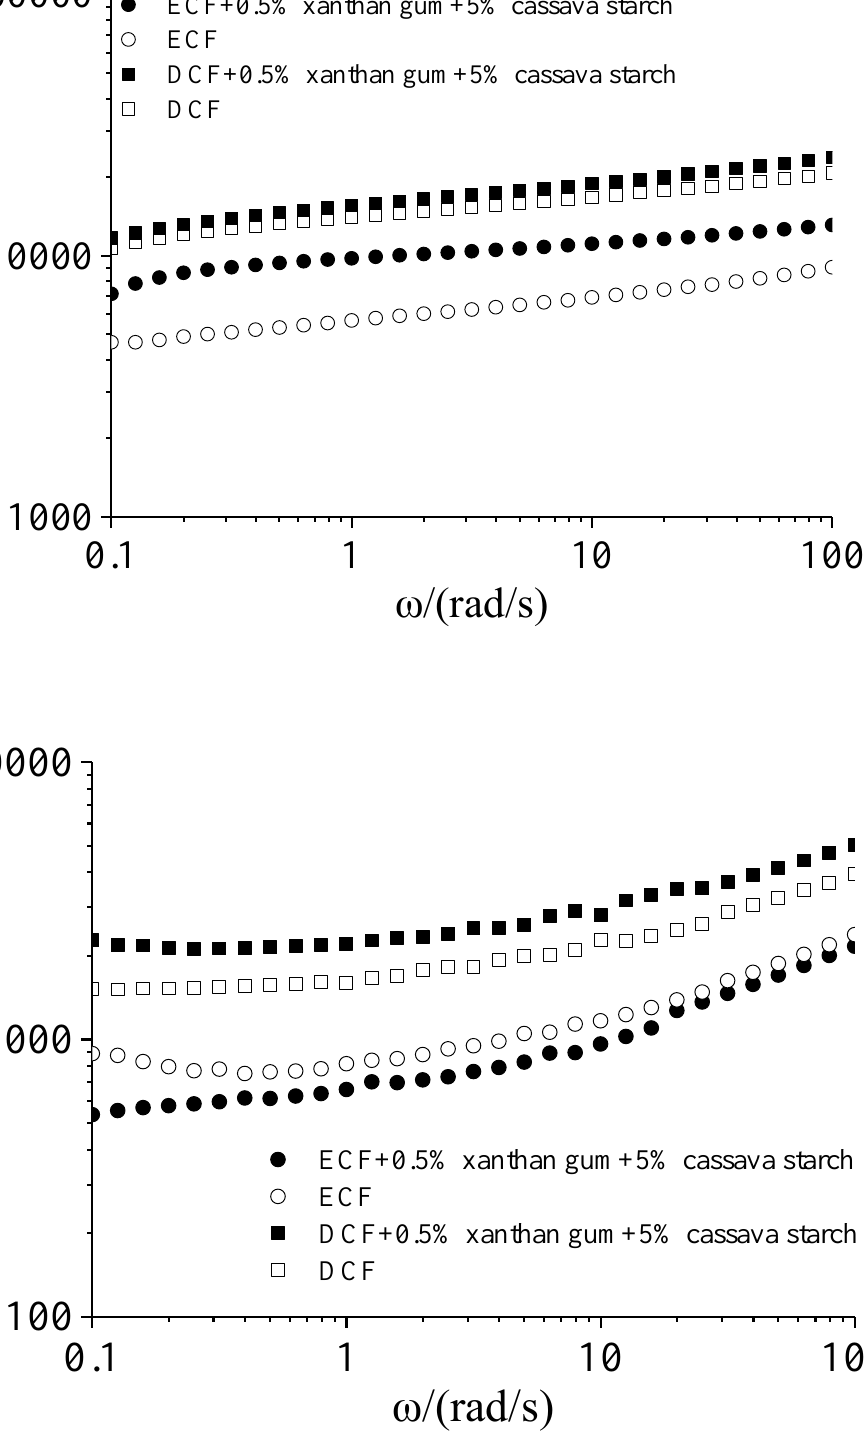
Figure 6. Frequency sweep of tortillas. ( A ): Storage modulus G′; ( B ): loss modulus G″. DCF: dry-milling corn flour; WCF: wet-milling corn flour; ECF: enzymatic wet-milling corn flour. ●: enzymatic wet-milling corn flour + 0.5% xanthan gum + 5% cassava starch; ○ : enzymatic wet-milling corn flour; ■ : dry- milling corn flour + 0.5% xanthan gum + 5% cassava starch; □: dry -milling corn flour.